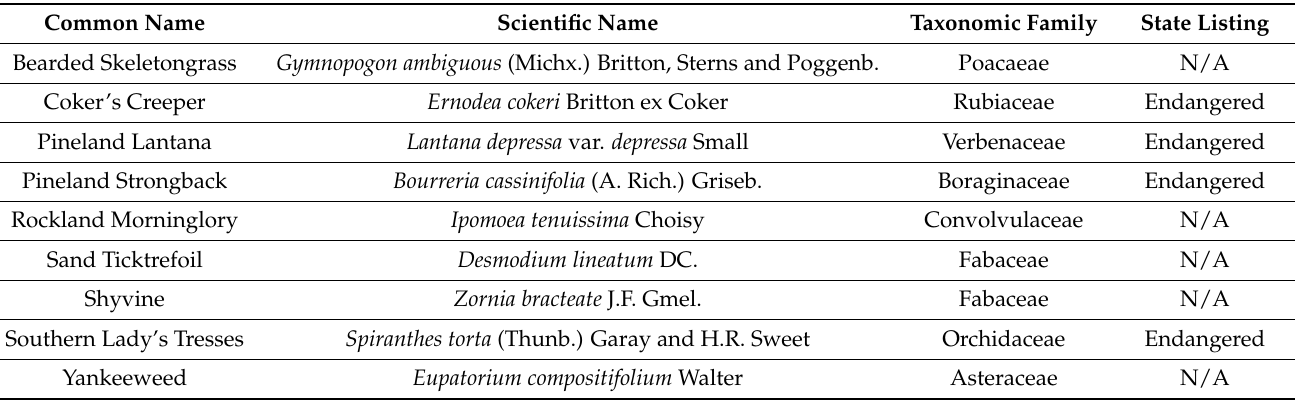
Table 3. List of nine critically imperiled plant species found in the Richmond pine rocklands, as identified by the Florida Natural Areas Inventory and Institute for Regional Conservation. Florida state listing of each plant species (if applicable) is in the rightmost column of the table (data from the Richmond Tract Management Plan; Possley et al. 2018). All abovementioned species are dependent on fire for their